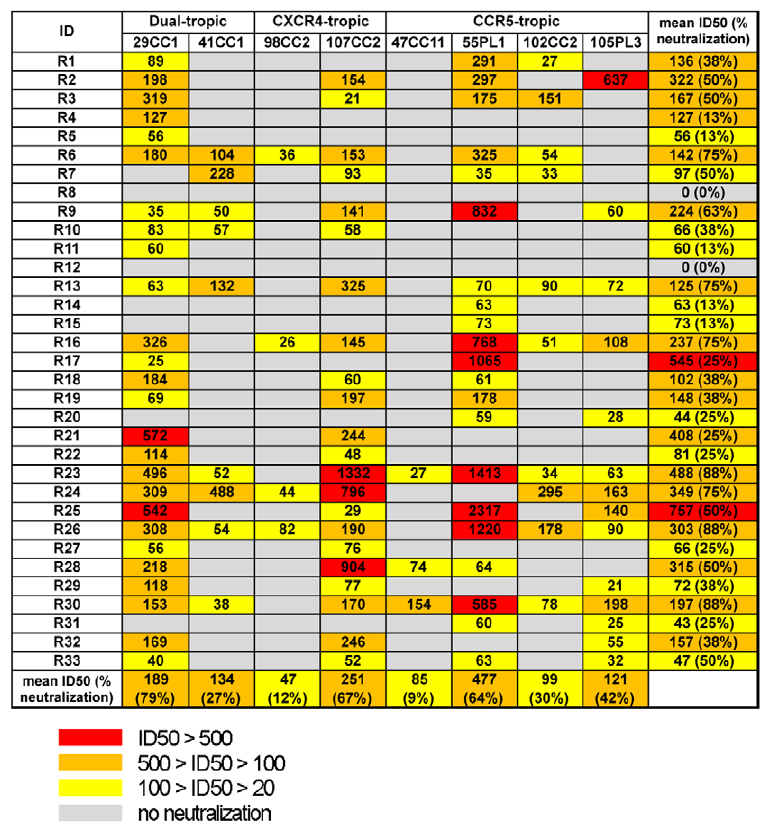
Figure 1. Anti-HIV-1 neutralizing activity of plasma derived from 33 rapid progressors against AE-Env-recombinant viruses. Neutralizing activity of plasma samples against 8 AE-Env-recombinant viruses was evaluated and reciprocal plasma dilution at which viral replication was suppressed by 50% (50% inhibitory dilution, ID50) was calculated, as described in Methods. Data are presented as the means of at least three independent experiments. Plasma IDs and AE-Env-recombinant viruses tested are denoted on the left side and above the panel, respectively. In addition, mean ID50 values and the percentages of virus/plasma combinations (% neutralization) in which viral neutralization was observed among the data sets in horizontal and vertical directions are shown on the right side and bottom of the panel, respectively. ID50 values . 500, values 100– 500, and values 20–100 are highlighted in red, orange and yellow, respectively. In addition, no neutralization (ID50 values , 20) of a recombinant virus is denoted by a gray background.